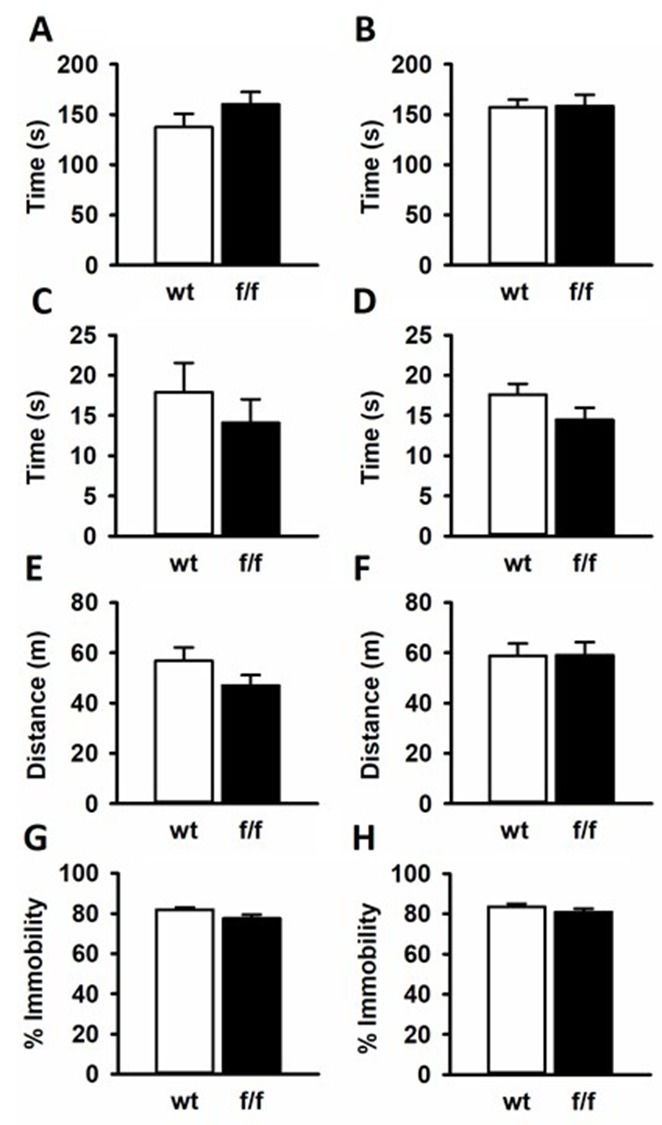
SD:nr3c1fl/fl (f/f) rats did not show behavioral differences from SD:nr3c1wt (wt) controls in common behavioral assays.Male (A) and female (B) f/f and wt controls spent equal time in the open arms of the elevated plus maze. Males (C) and females (D) showed no differences in time spent in the center of the open field. No locomotor phenotype was observed in male (E) and female (F) f/f rats compared to wt controls in the open field. There were no differences in immobility in the forced swim test for male (G) or female (H) f/f rats compared to controls.